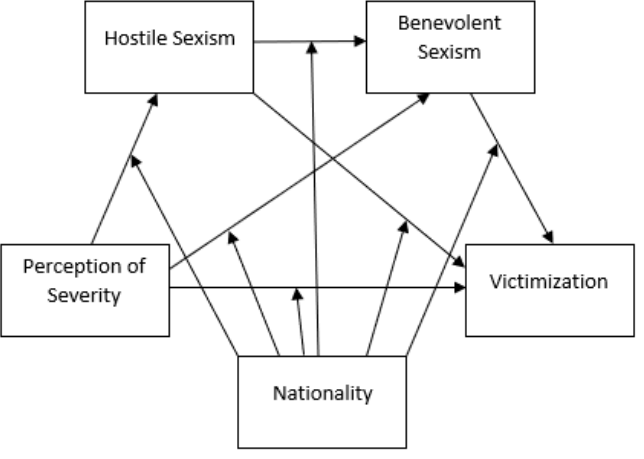
Figure 2. Moderate mediation model 92.